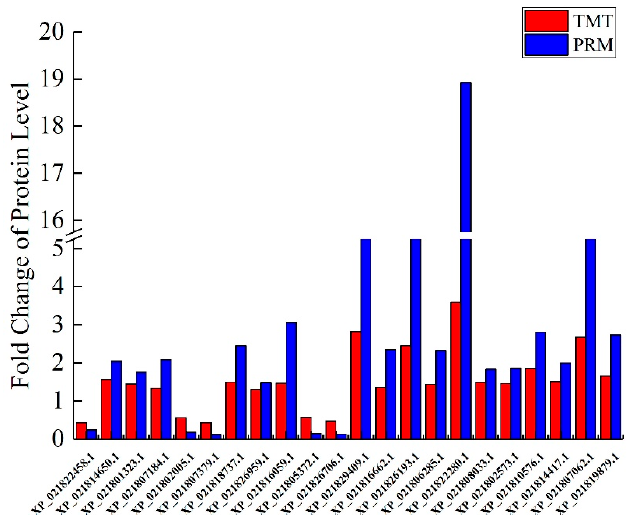
Figure 7. Confirmation of 22 selected differentially produced proteins detected by the Parallel Reaction Monitoring (PRM) technique. The ordinate represents the CA/CN ratio value, ratio > 1 represents the up-regulation, and ratio < 1 represents the down-regulation.